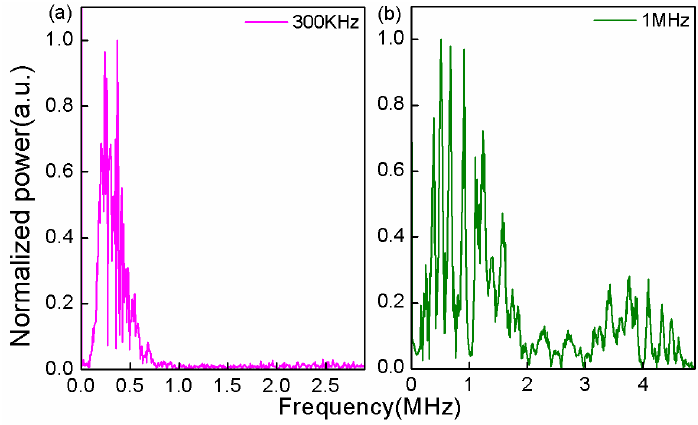
Figure 4. Frequency domain spectra of UW at the frequencies ( a ) 300 kHz; ( b ) 1 MHz.